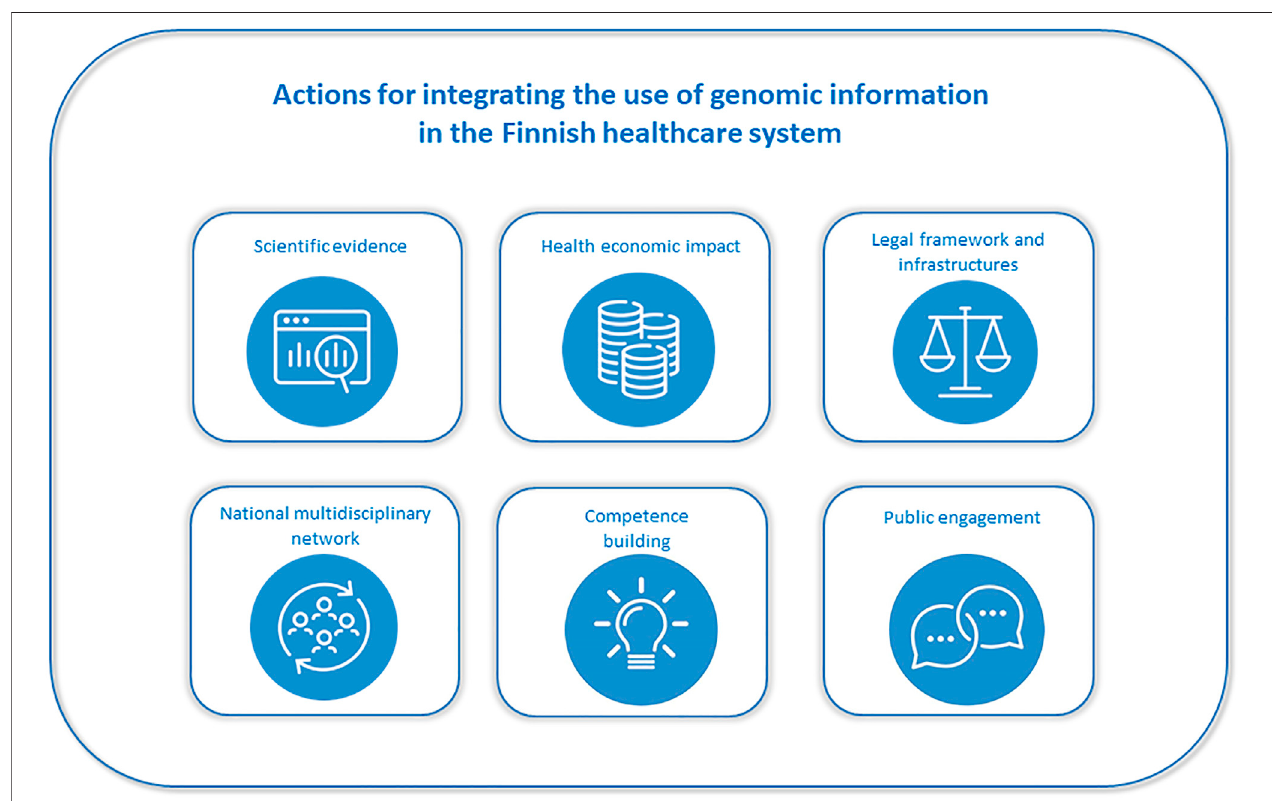
FIGURE 2 | Integrating the use of genomic information in the Finnish healthcare